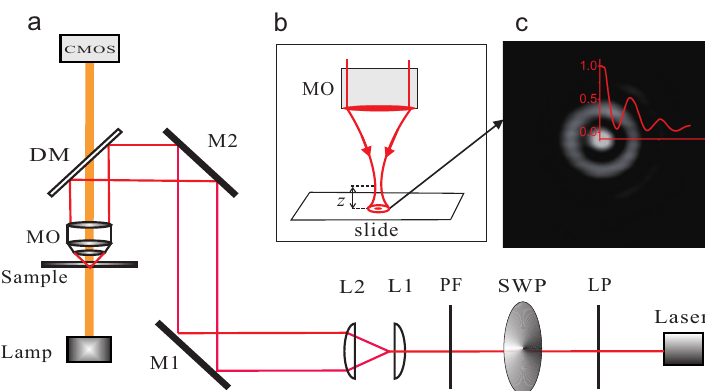
Figure 1. ( a ) optical tweezers setup. Instrument layout showing optical paths for 1064 nm trapping laser and lamp for bright imaging. L1–L2, lens; M1–M2, mirrors; MO, microscope objective; DM, dichroic mirror; SWP, s-waveplate; LP, linear polarizer; PF, polarization filter; ( b ) schematic illustration of the focal region produced inside the sample cell. z is the trapping depth; ( c ) diffraction pattern and light intensity distribution (a.u.) on the